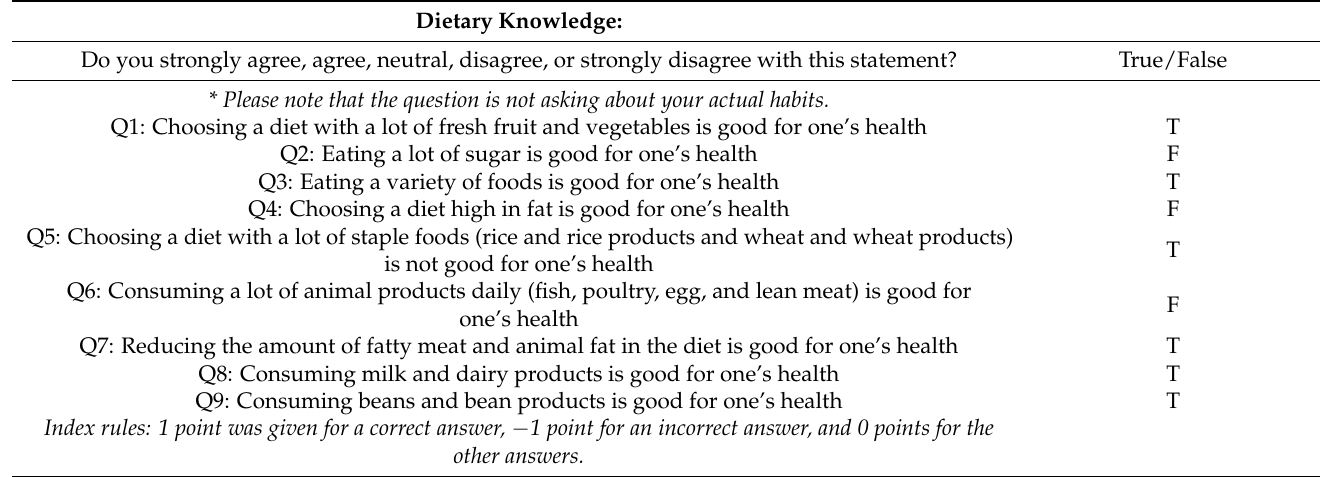
Table A1. Questions Concerning Dietary Knowledge in the